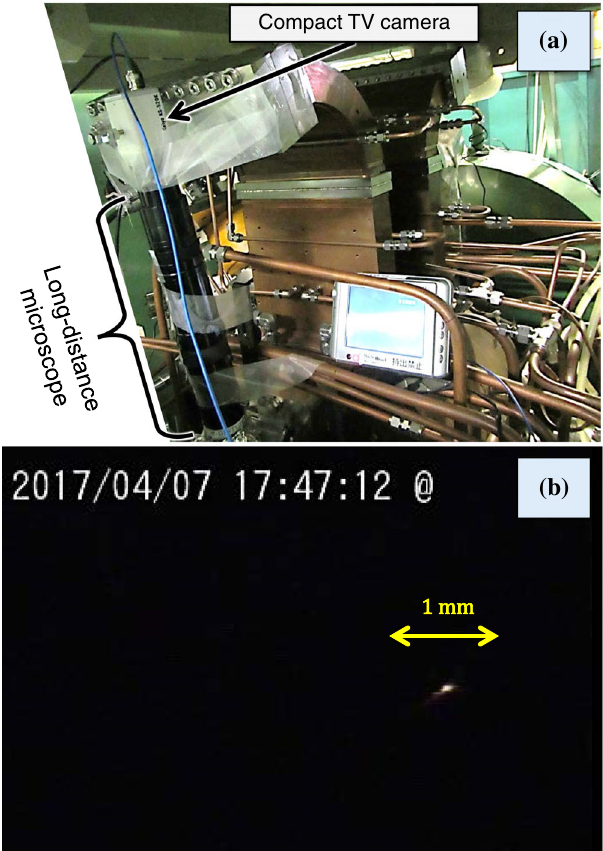
FIG. 18. Magnified image of the stable bright spot BS-C1. (a) Setup with the long-distance microscope. (b) Image obtained at V c ¼ 0 . 45 MV with the contrast of the image enhanced by 50% relative to the original contrast.